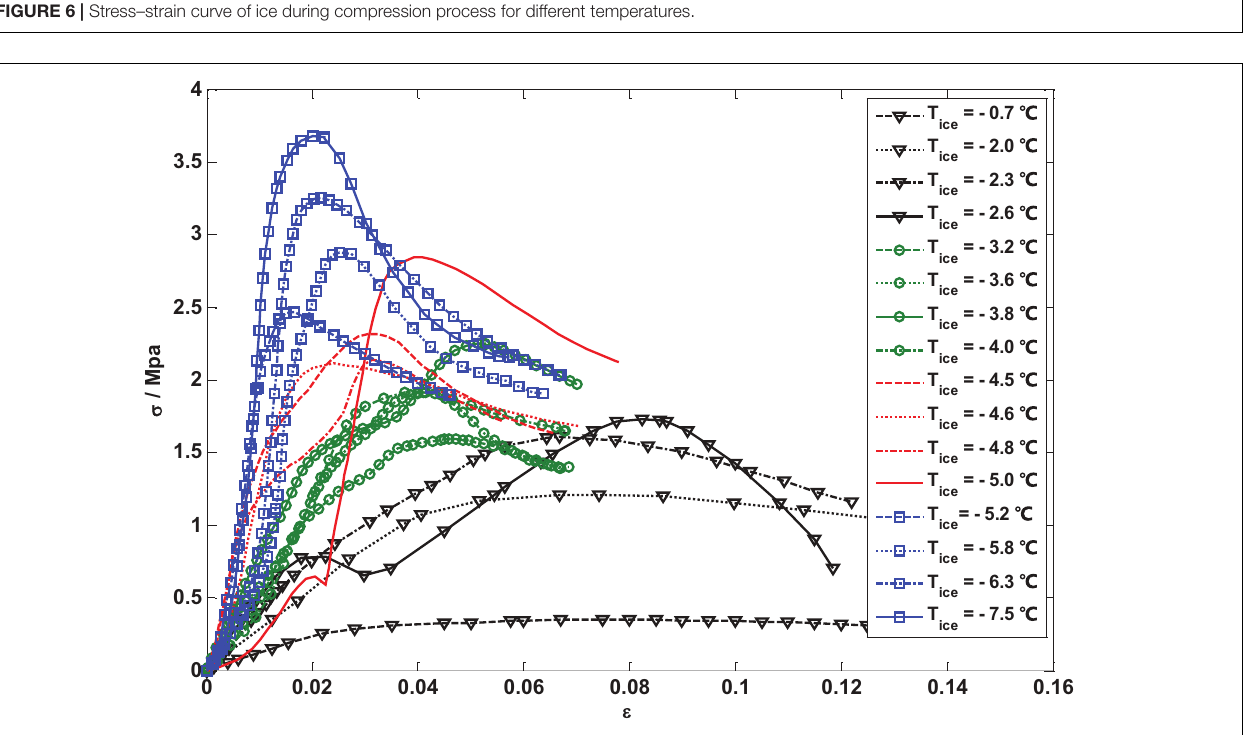
FIGURE 7 | Stress–strain curve of ice with various temperatures during compression process.